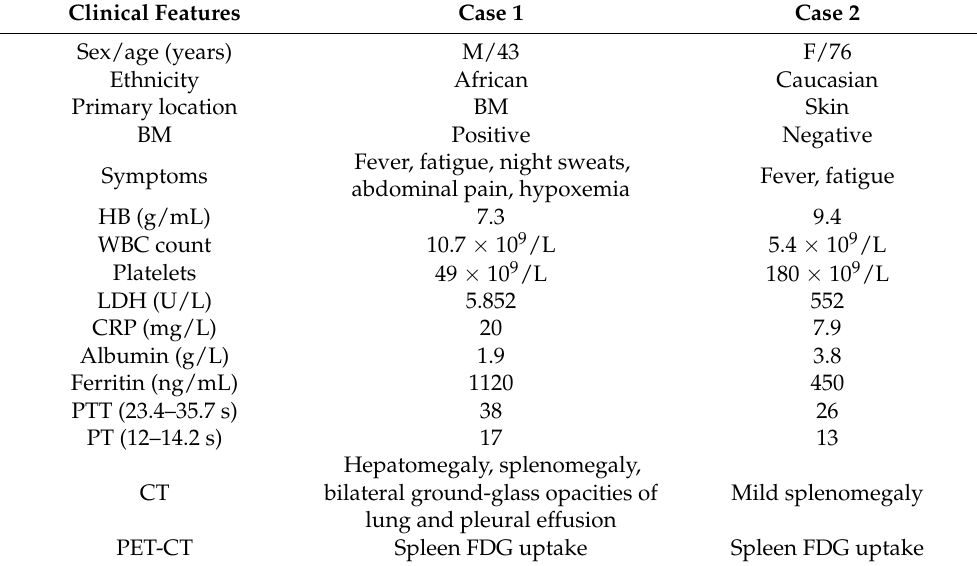
Table 1. Clinical features of the two patients.